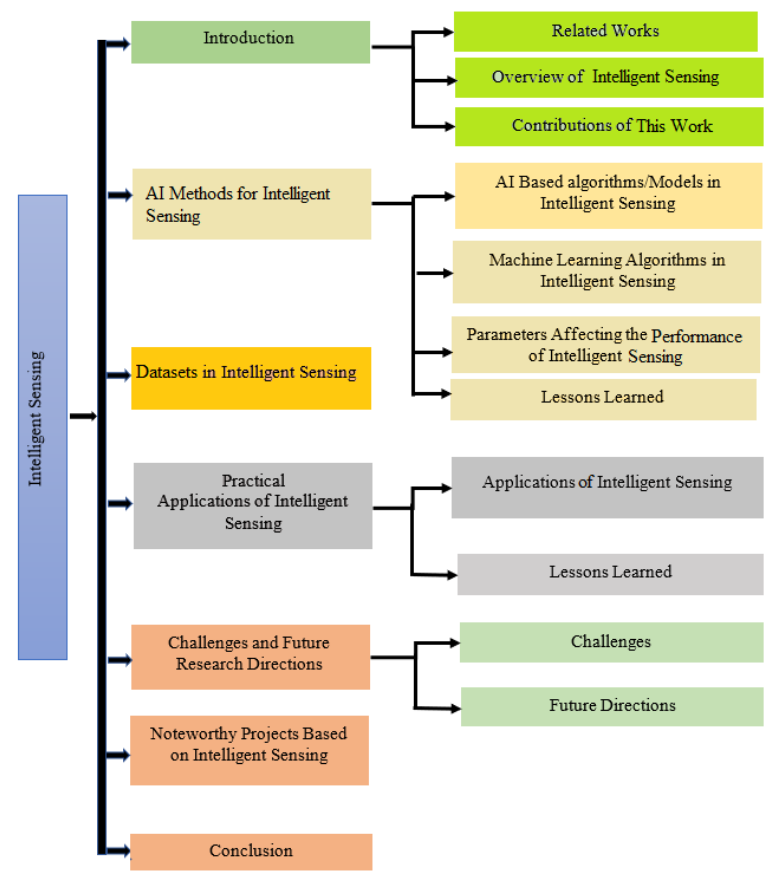
Figure 1. Structure of the